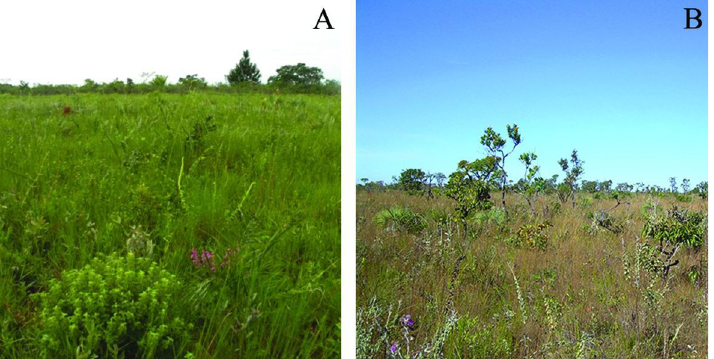
Fig 1. Overview of study site. Images illustrate the vegetation during the rainy (left) and dry (right) seasons at the Reserva Ecolo´gica do IBGE, Brası´lia, Brazil (Photographs by S. C.